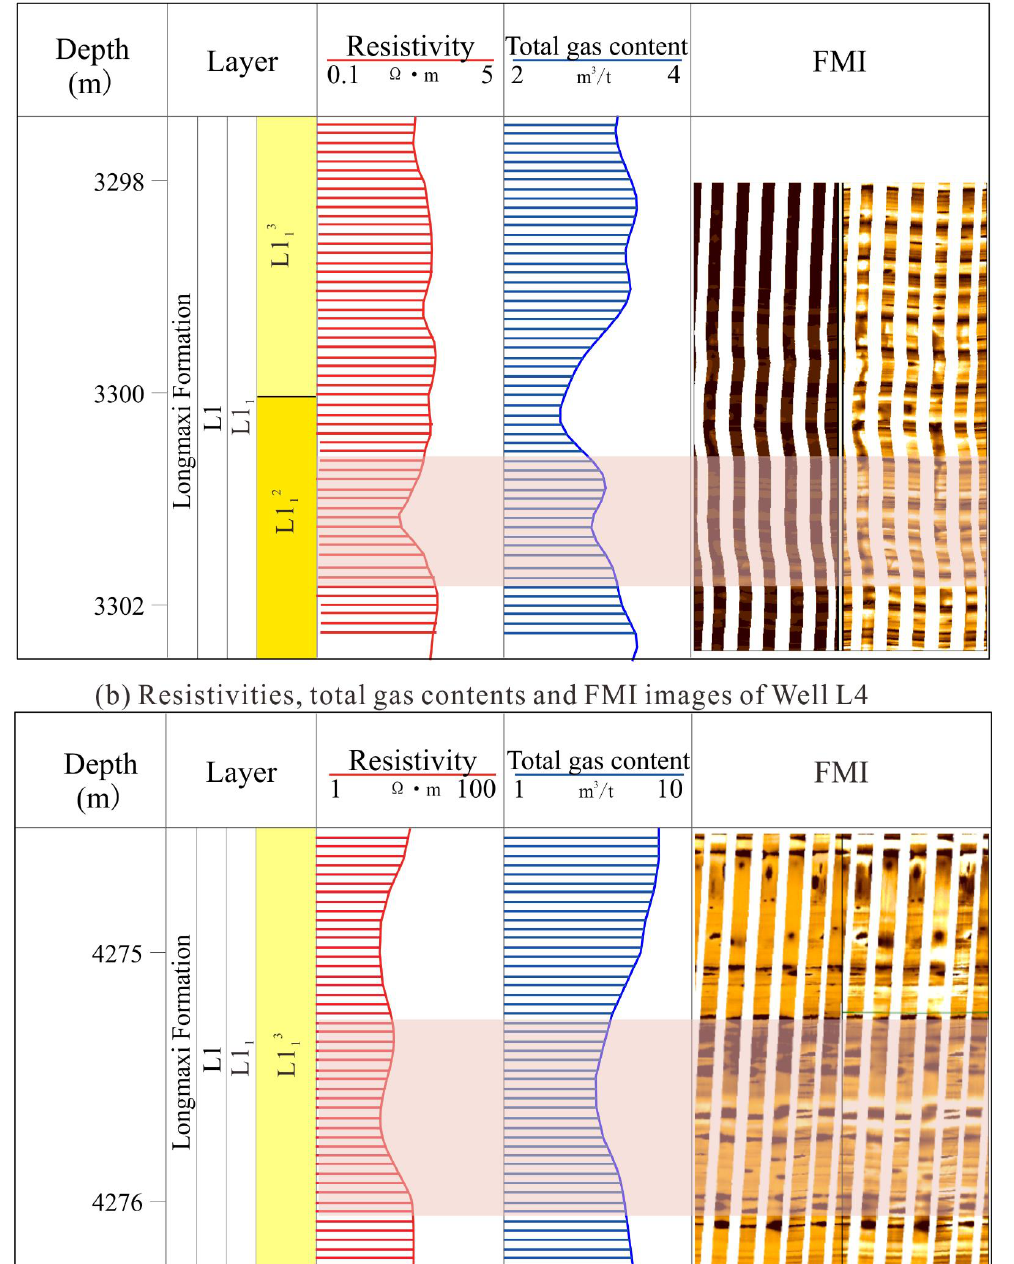
Figure 11. FMI images indicating natural fractures resulted small decrease in electrical resistivities, ( a ) relationship among resistivities, total gas contents and FMI images of well N6, ( b ) relationship among resistivities, total gas contents and FMI images of well L4.